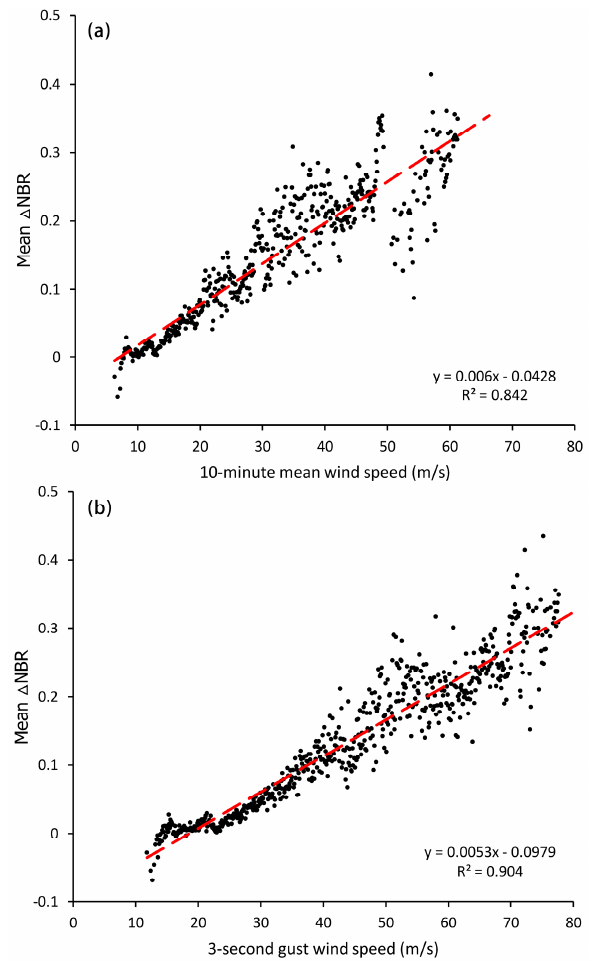
Figure 8. Scatter diagrams between mean and simulated wind fields of 10-minute mean (a) and 3-second gust